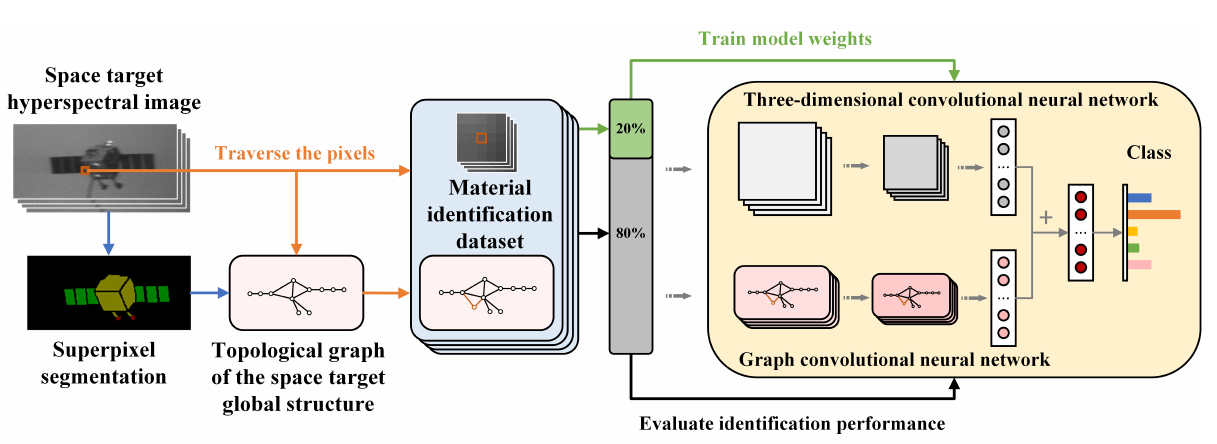
Figure 6. An overview of the proposed